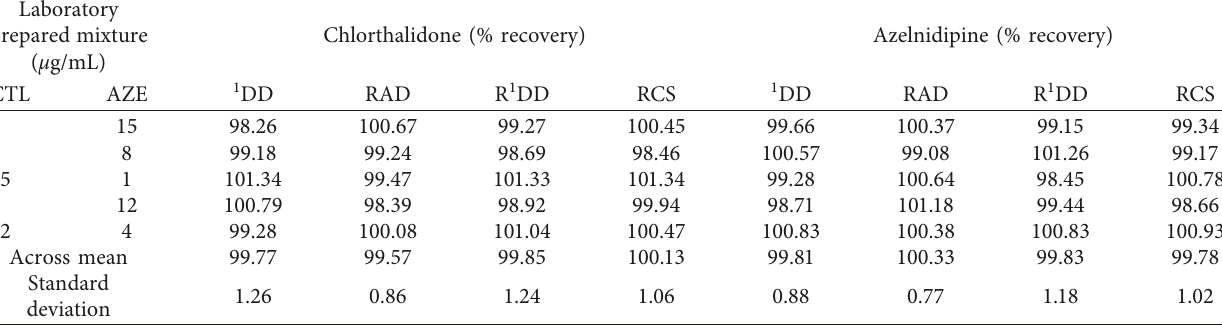
Table 2: Assay results of the laboratory mixed solutions of CTL and AZE.